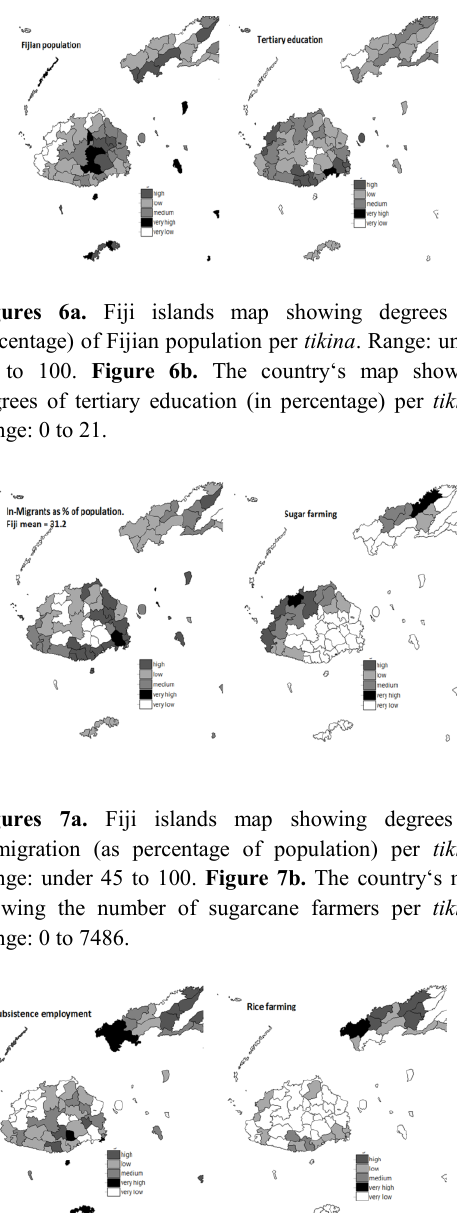
Figures 8a. Fiji islands map showing degrees of subsistence employment per tikina . Range: 0 to 74.7% of labour force. Subsistence activities employed the half of the labour force in 1996 with a value of nearly 6% of the GDP (Walsh and Crosbie 2006). Figure 8b . The country‘s map showing the number of rice farmers per tikina . Range: 0 to 158 farmers. Sugar was Fiji‘s main export until 1988, currently employs a quarter of the active labour force (Walsh and Crosbie